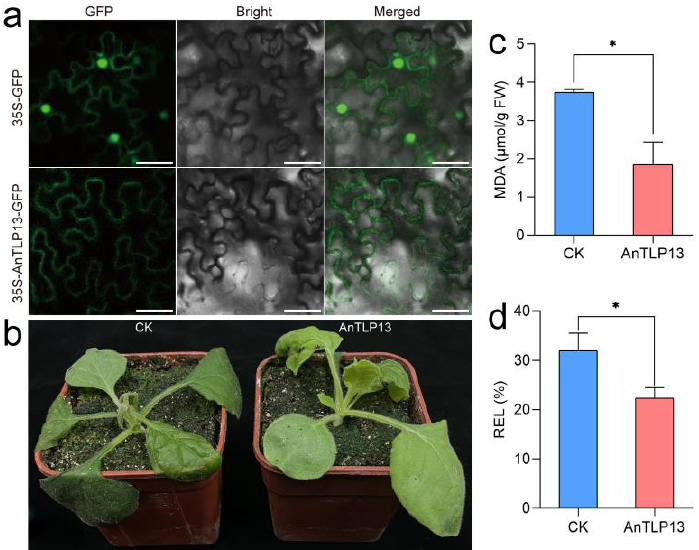
Figure 11. Overexpression of the AnTLP13 gene enhanced the tolerance of tobacco seedlings to freezing stress. ( a ) Subcellular localization analysis of AnTLP13 during transient expression in tobacco. Bars = 50 μm. ( b ) Tobacco seedlings of CK and AnTLP13 group were transferred to − 4 °C for freezing-stress treatment for 12 h. ( c ) The MDA content of tobacco leaves after freezing-stress treatment. ( d ) The values of electrolyte leakage (REL) of tobacco leaves after freezing-stress treatment. ‘*’ indicated p < 0.05.